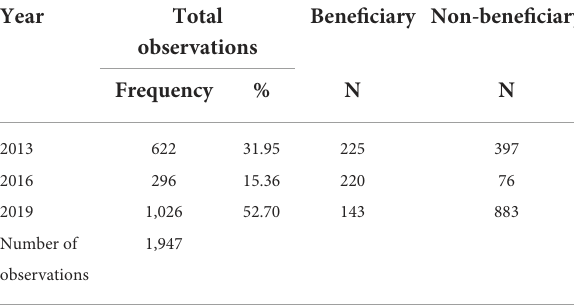
TABLE 3 Descriptive statistics of the explanatory variables by beneficiary category.